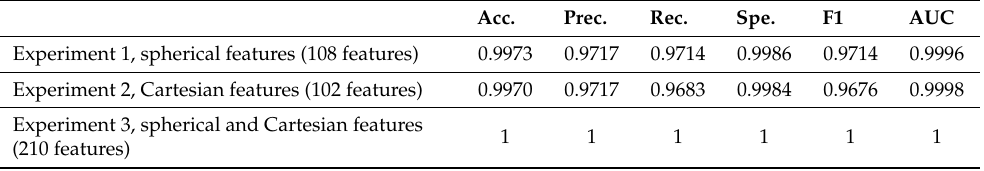
Table 7. Average values of the metrics obtained from three experiments using different combinations of